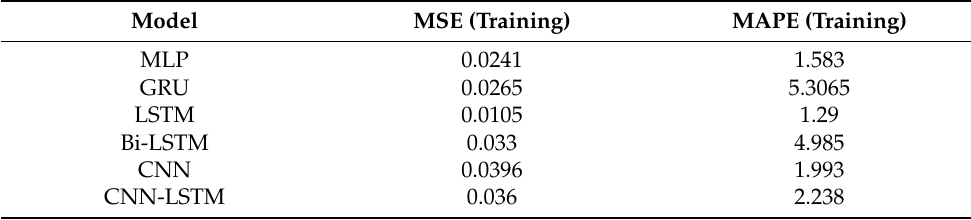
Table 2. The training results of the models using Apple data with four input